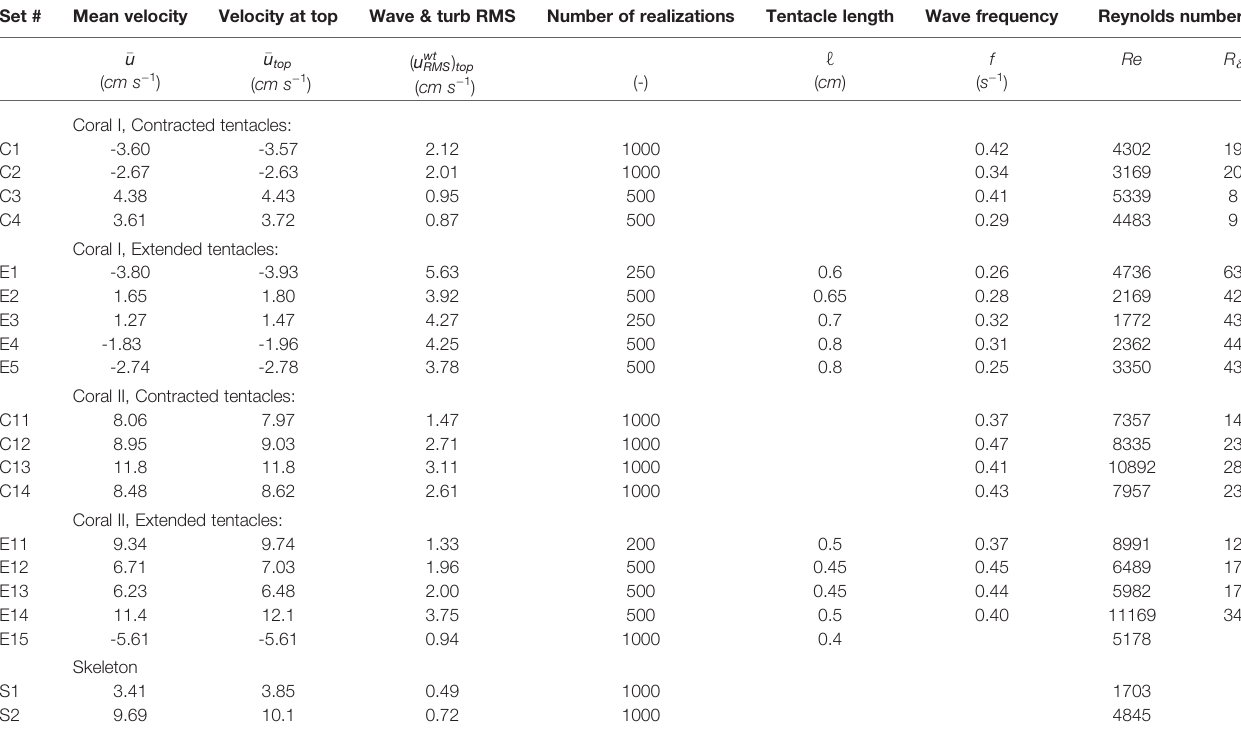
TABLE 1 | Experimental conditions including the spatial and temporal mean (in space and time) velocity in the x direction (positive is north to south), the mean velocity at the top of the measured domain, the root mean square of the wave and turbulent fl uctuating velocity, u w + u t , the number of realization, the tentacle length, the dominant wave frequency, and two Reynolds numbers.